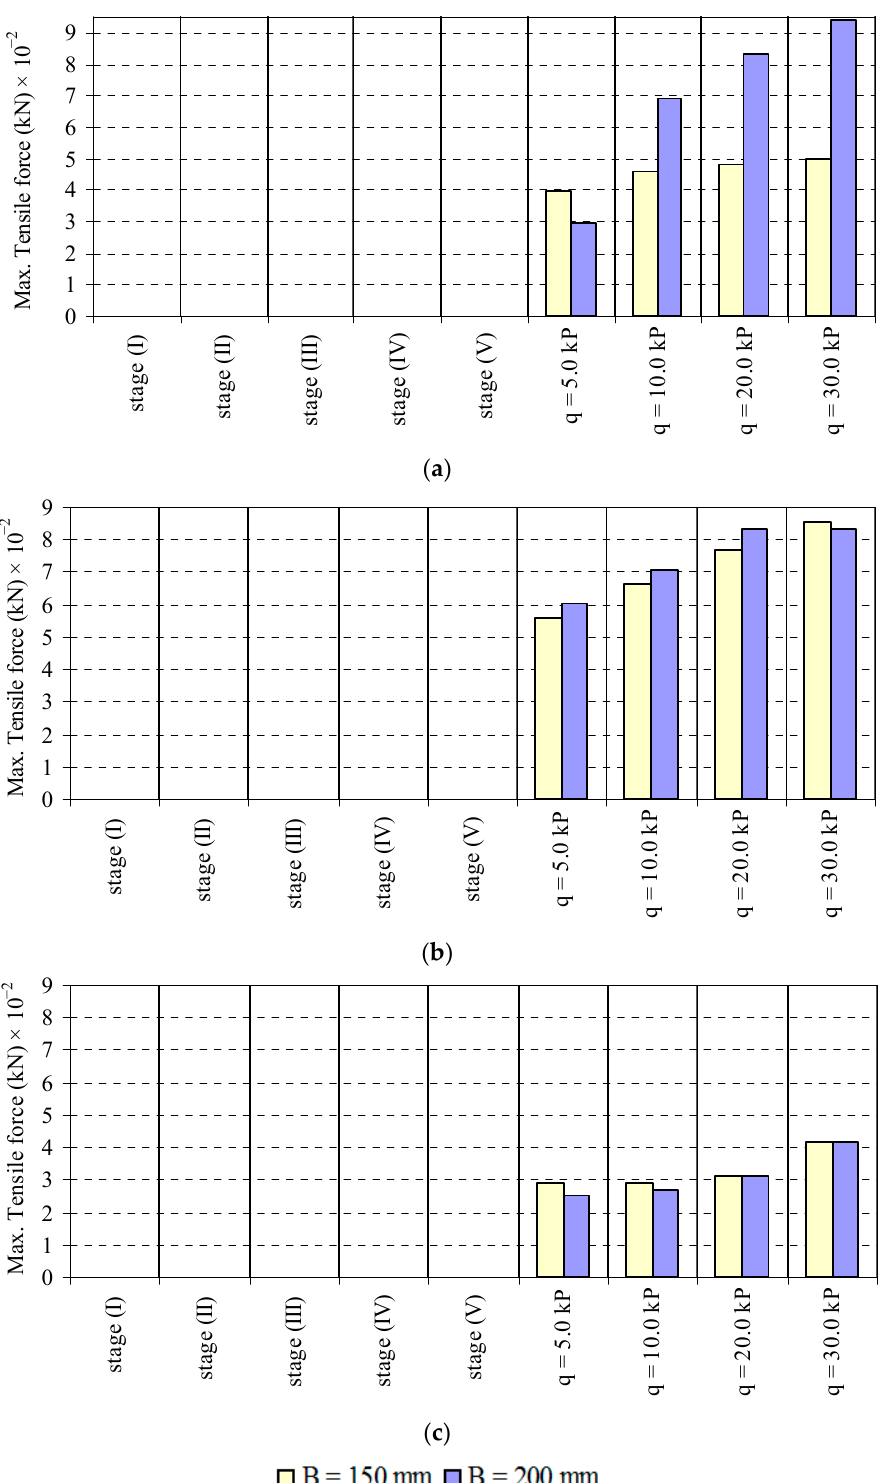
Figure 21. Influence of footing width on the maximum tensile force of the footing; ( a ) upper nail; ( b ) middle nail; ( c ) lower nail.